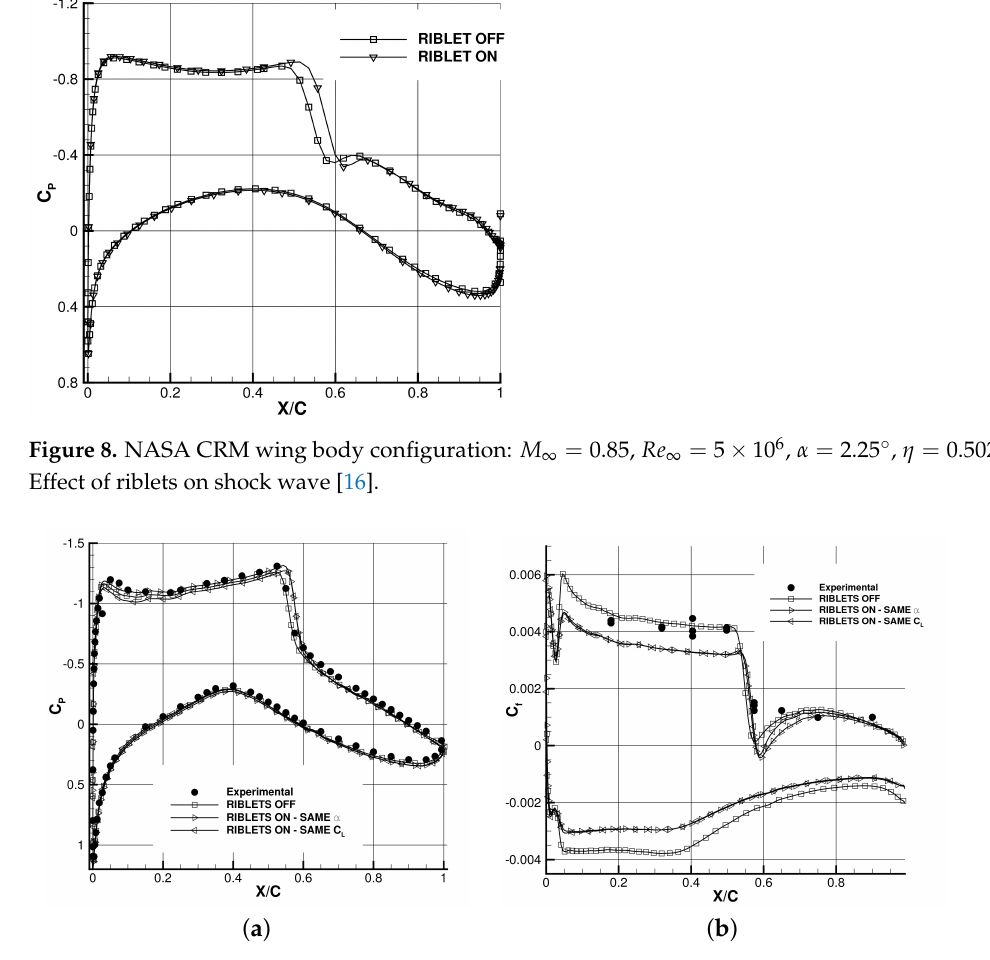
Figure 9. RAE 2822 airfoil: M ∞ = 0.734, Re ∞ = 6.5 × 10 6 , α = 2.79 ◦ . ( a ) Pressure coefficient; ( b ) skin friction coefficient